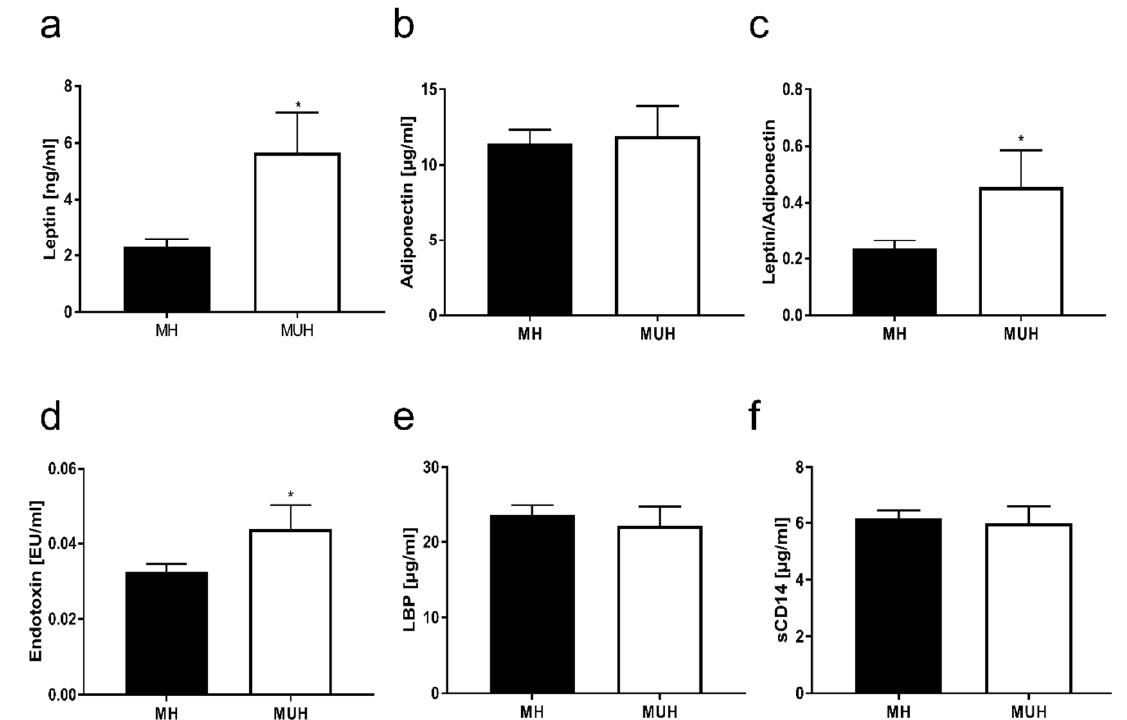
Figure 2. ( a ) Leptin and ( b ) adiponectin plasma levels, ( c ) leptin/adiponectin ratio, ( d ) endotoxin plasma levels, ( e ) LBP plasma and ( f ) sCD14 serum levels in metabolically healthy children (MH) and children suffering from metabolic abnormalities (MUH). Data are shown as mean ± SEM, * p ≤ 0.05 compared to healthy children. LBP: Lipopolysaccharide binding protein, sCD14: soluble CD14.